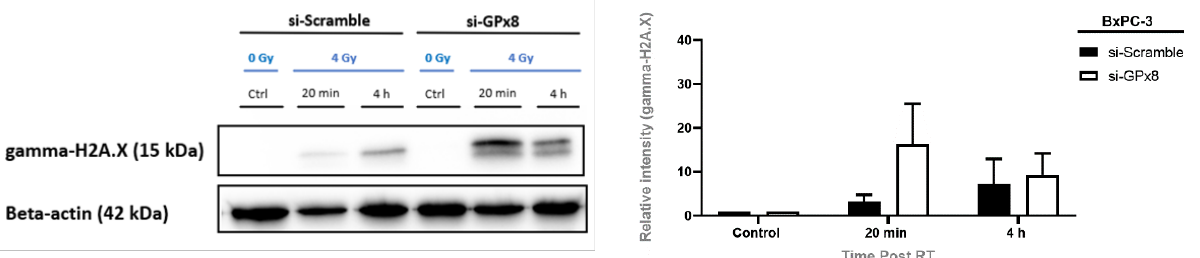
Figure 12. Silencing GPx8 increases gamma-H2A.X levels post-radiation treatment. Representative Western blot time course and densitometric analysis for gamma-H2A.X as a marker of DNA damage with radiation treatment (RT) in si-GPx8 and si-Scramble BxPC-3 cells ( n = 3). A trend indicated that gamma-H2A.X levels were increased at 20 min post-RT in BxPC-3 cells with GPx8 silenced com- pared to its scramble control. However, no statistical significance was found. Two-way ANOVA with Tukey’s post-hoc test was adopted for statistical analysis, comparing si-GPx8 BxPC-3 cells to si-Scramble BxPC-3 cells at 20 min post-RT and 4 h post-RT.